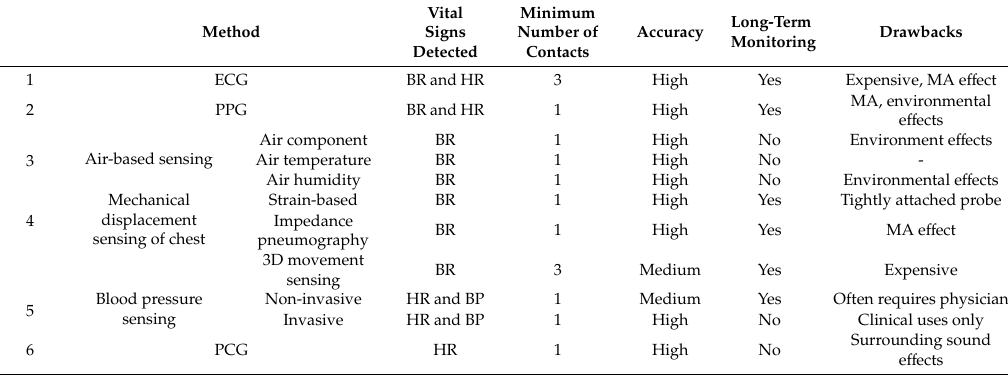
Table 1. Comparison of contact-based vital signs monitoring systems comparing them in terms of vital sign, number of contact needed, its accuracy and major